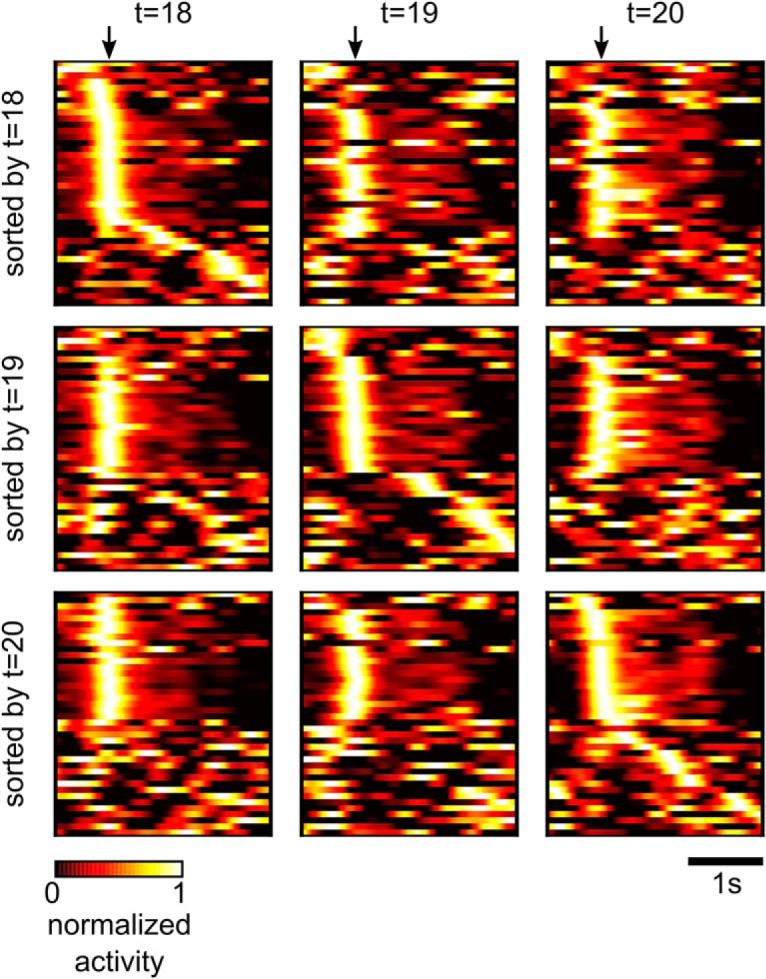
Drifts of neural codes while performance remained constant. Trial-averaged network activity as in Figure 3D evaluated at three different times selected from a time window where the network performance was stable (Fig. 3C). Each column shows the same trial-averaged activity plot but subject to different sorting. Rows correspond to one sorting criterion based on one evaluation time.